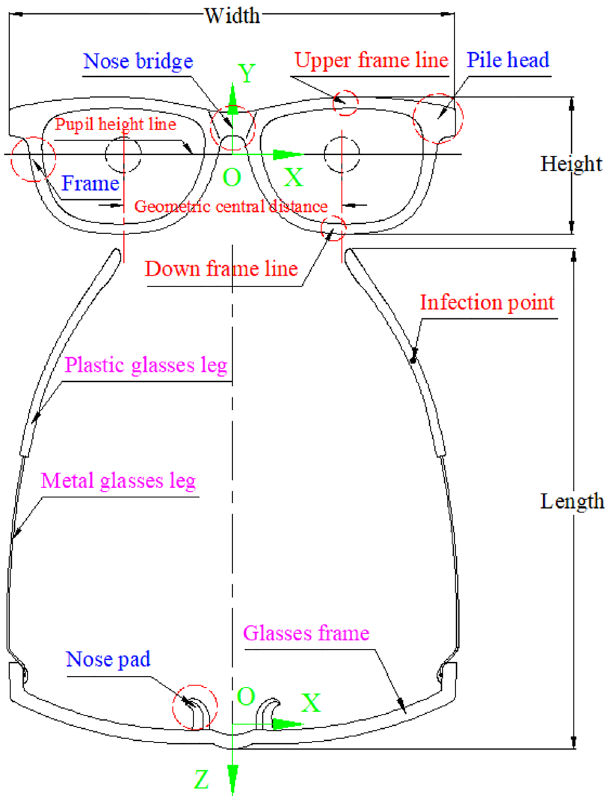
Figure 2. The components and coordinate system of the myopic